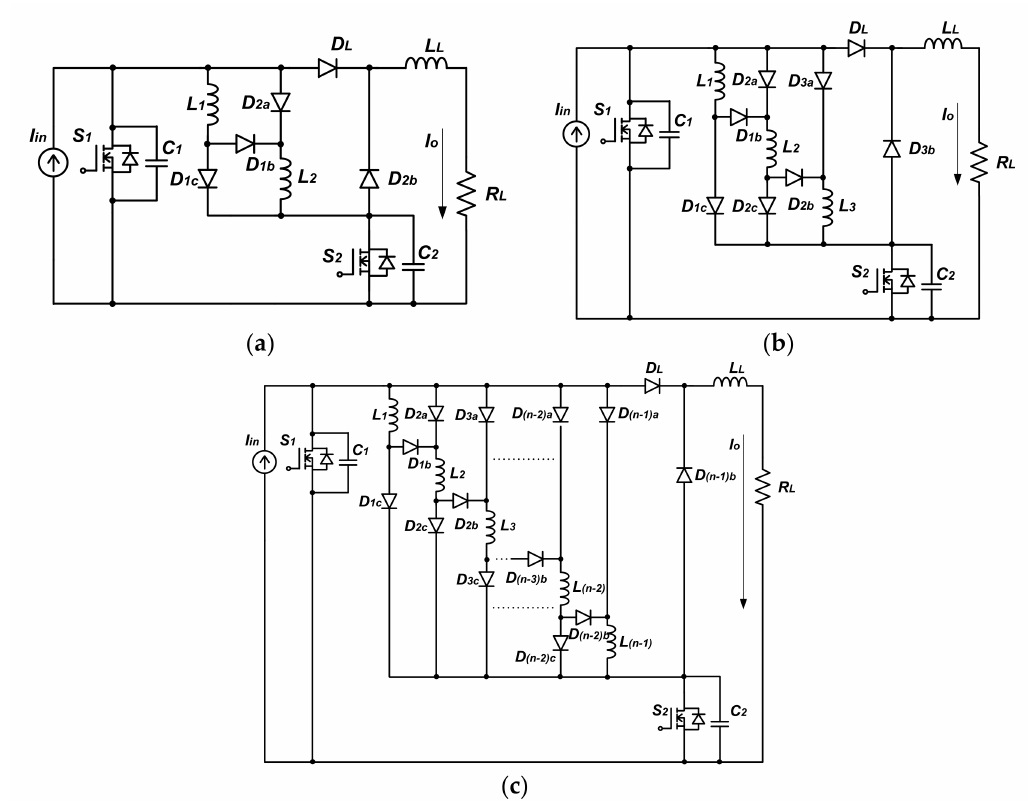
Figure 3. The step-down resonant switched-inductor converters using non-inverting design; ( a ) 1/3- type, ( b ) 1/4-type, ( c ) 1/ n -type.